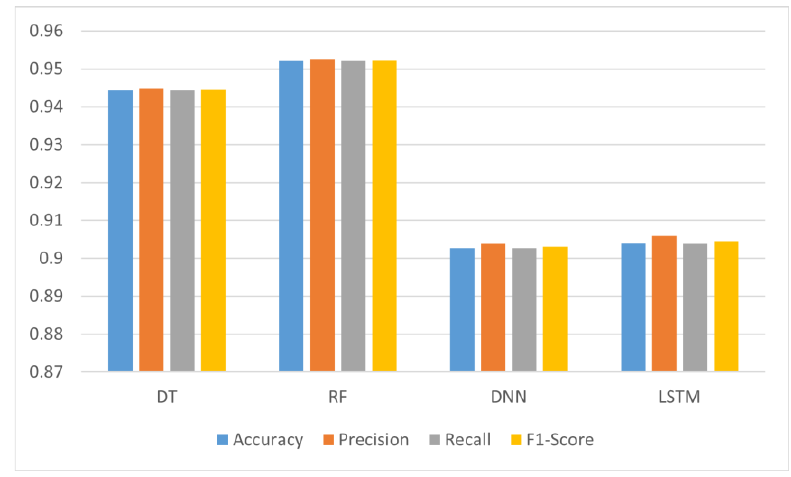
Figure 7. Values of the evaluation metrics for each candidate algorithm in setting 2.